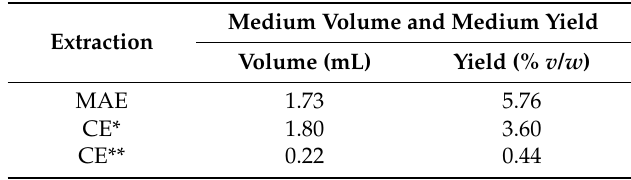
Table 3. Yield of P. emarginatus volatile oil by microwave-assisted extraction (MAE) compared to conventional extraction (CE).